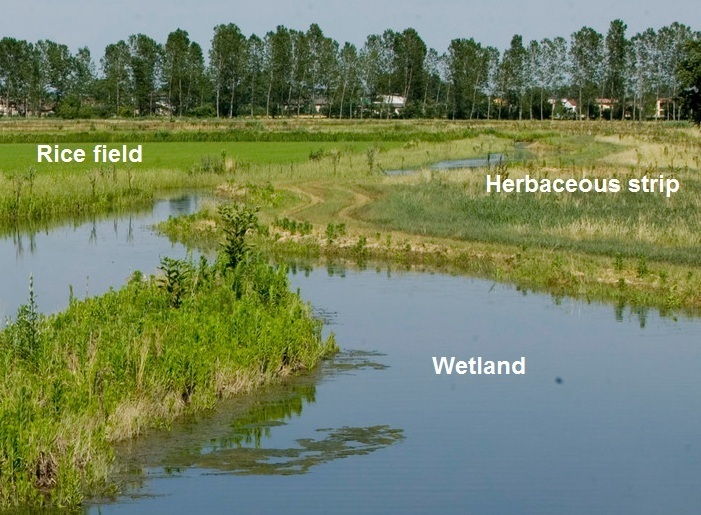
Herbaceous buffer strip along a small wetland connected to paddy field.